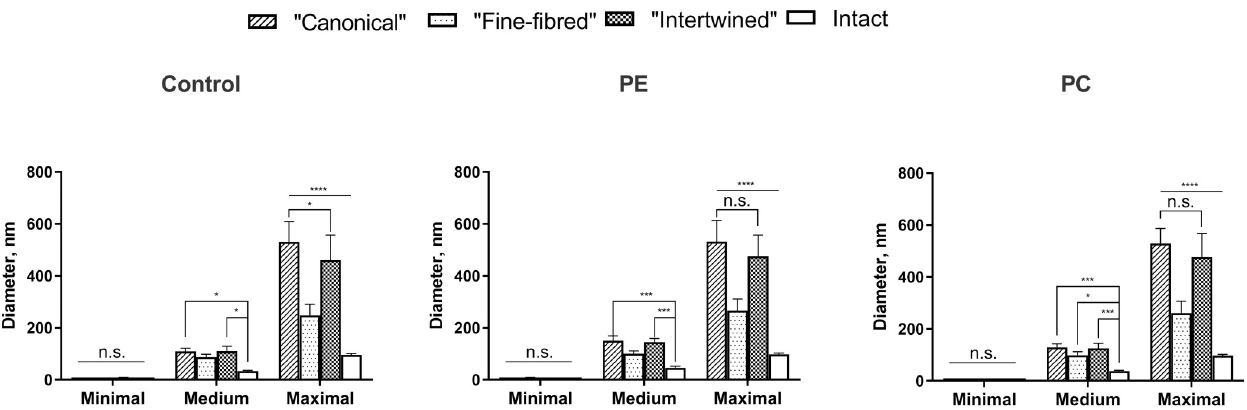
Fig 11. Diameters of collagen fibrils in different AT areas. Statistical significance: � —p � 0.05, ��� —p � 0.001, ���� —p � 0.0001, n.s.–non-significant. Two-way ANOVA followed by the Tukey’s test, mean values ± 95% confidence intervals.